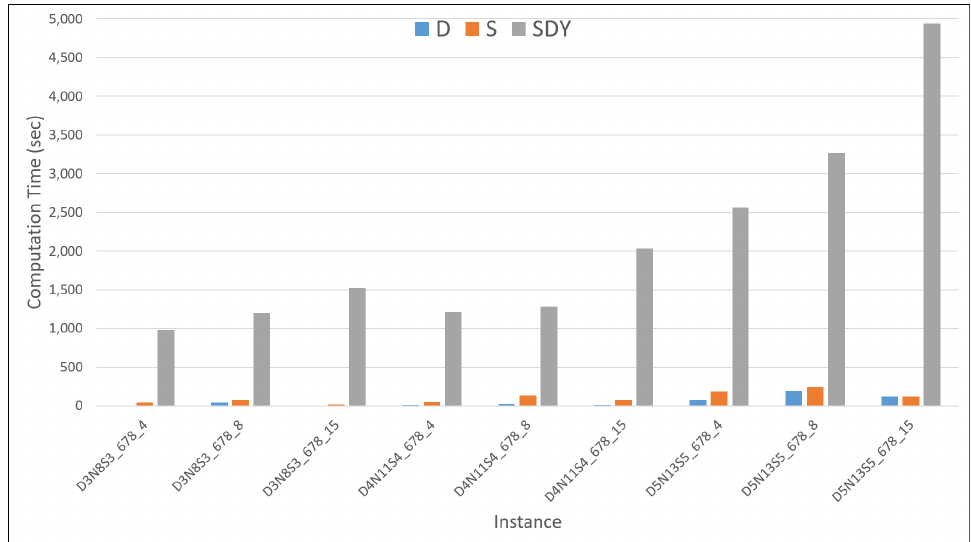
Figure A9. Computation Time for Maximum Road Capacity Setting ( 6,7,8 ) : Offline and Online Computation for all Instances based on Model Characteristic.